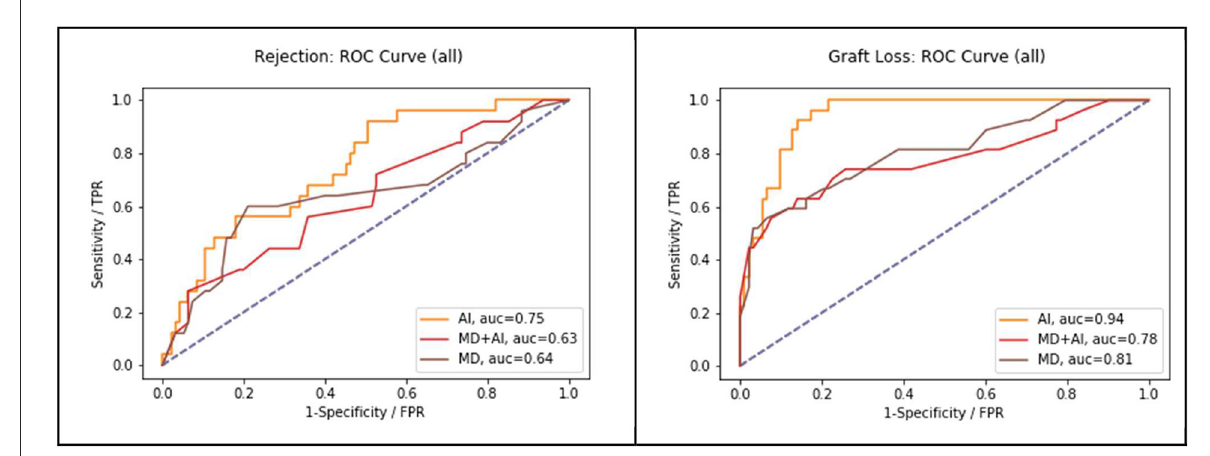
FIGURE2 Performance of MD in comparison to AI and MD + AI, in terms of AUC-ROC on all three endpoints.